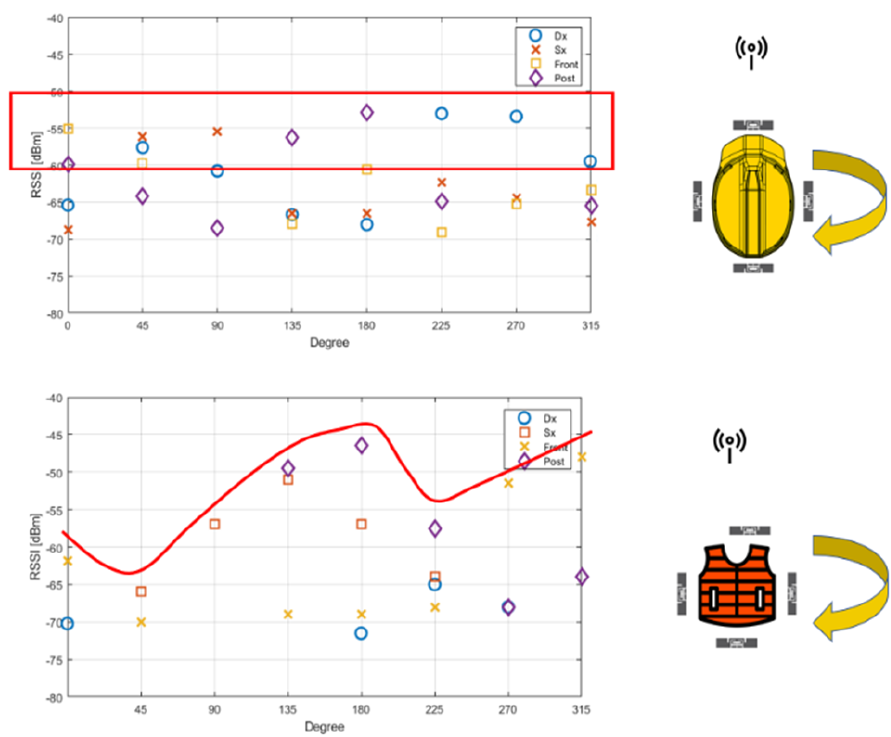
Figure 5. Measured RSSI for both tag configurations, when varying the source angle.